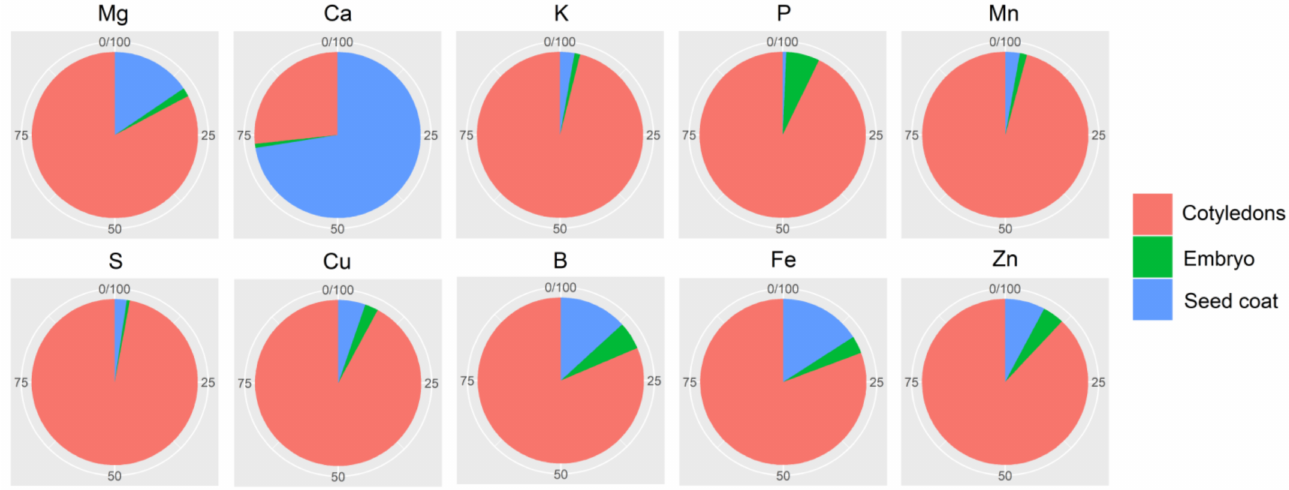
Figure 6. Mean percentage contents of 10 minerals in the seed coat, cotyledon, and embryonic axis of the grains of 10 bean ( Phaseolus vulgaris L.) cultivars derived from different centers of